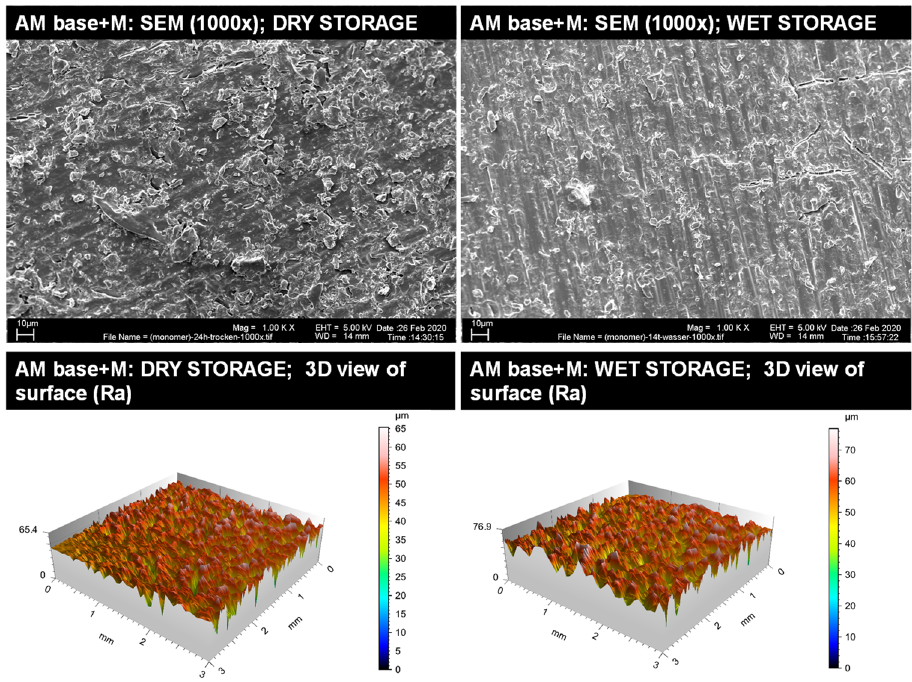
Figure 6. Qualitative insight of the AM base group conditioned with MMA (M) via SEM imaging in 1000× magnification ( top ) and surface roughness profiles ( below ) for dry storage ( left ) and wet storage ( right ). Please note the differences in the scaling of the roughness profiles.